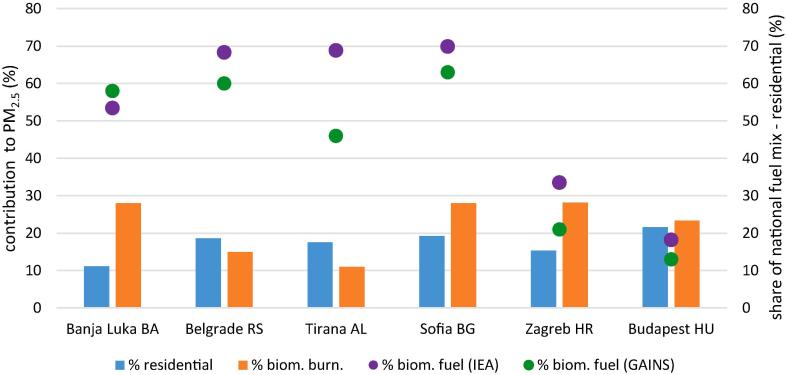
Impacts of the residential sector to PM2.5 estimated with SHERPA (this study, blue bars) and biomass burning contributions obtained with receptor models (from the literature, orange bars) in six cities of the study. The shares of biomass burning to the national fuel mix in the residential sector reported by IEA for 2012 (purple dots) and in the GAINS CLE scenario for 2013 (green dots) are also displayed for the respective countries. (For interpretation of the references to color in this figure legend, the reader is referred to the web version of this article.)